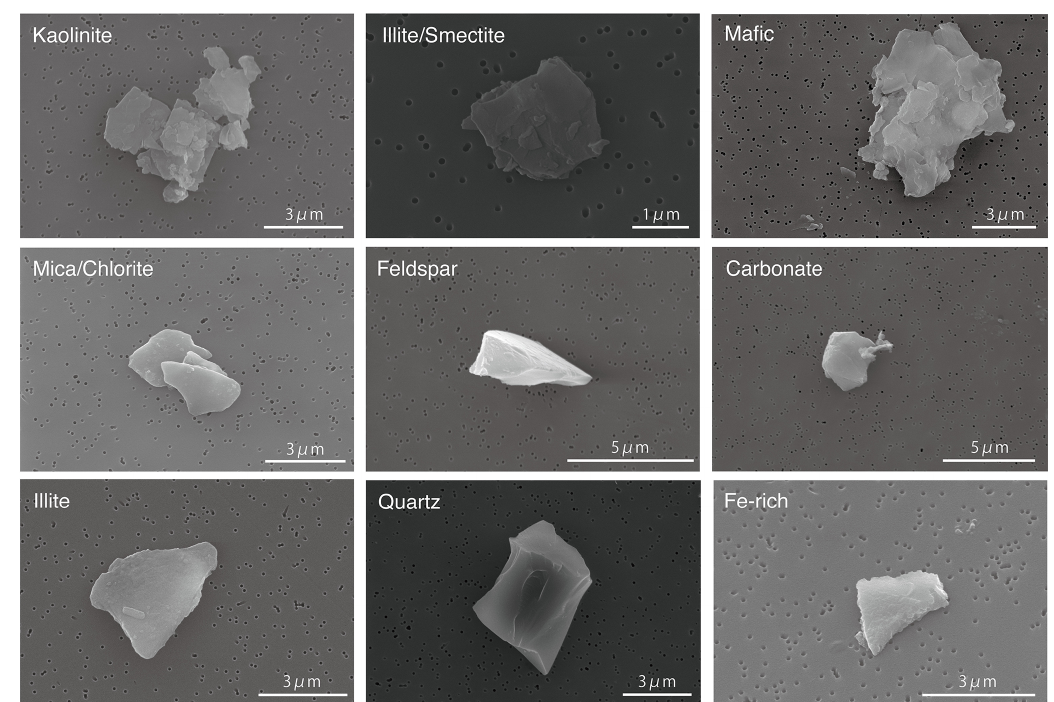
Figure 3. SEM images of each mineral group in the SIGMA-D ice